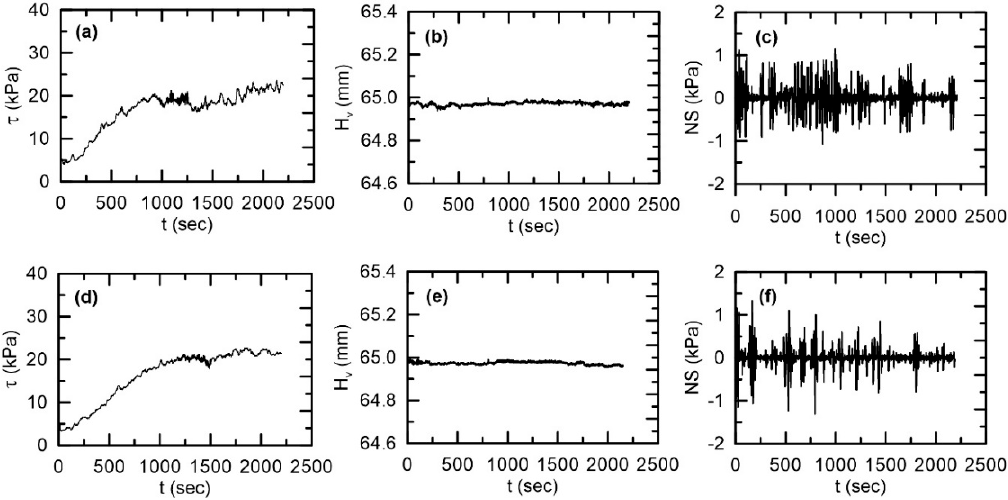
Figure 3. Shear characteristics of gravels using smooth surface test box: ( a – c ) Drained and ( d – f ) undrained conditions at 0.5 mm / s. τ = Shear stress (kPa); H v = Height of soil sample (mm); NS = Normal stress (kPa).